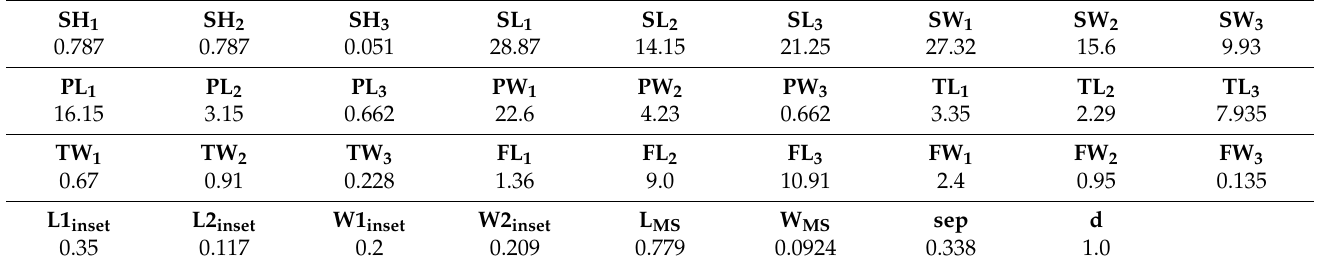
Table 1. Dimensions of the triple-band antenna structure (units in mm).